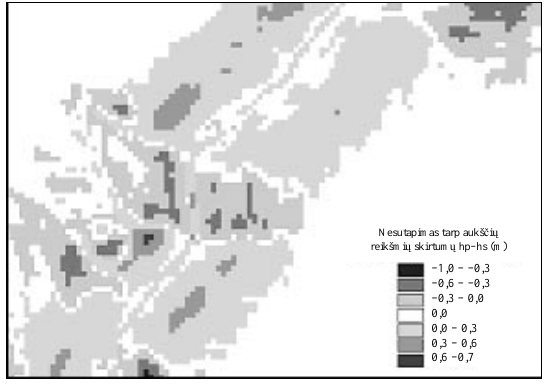
Fig 9. Differences between calculated and predicted values of neighbourhood